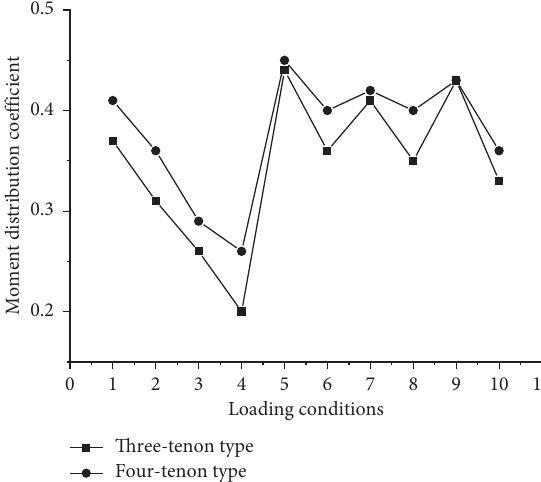
Figure 12: Results of moment adjustment